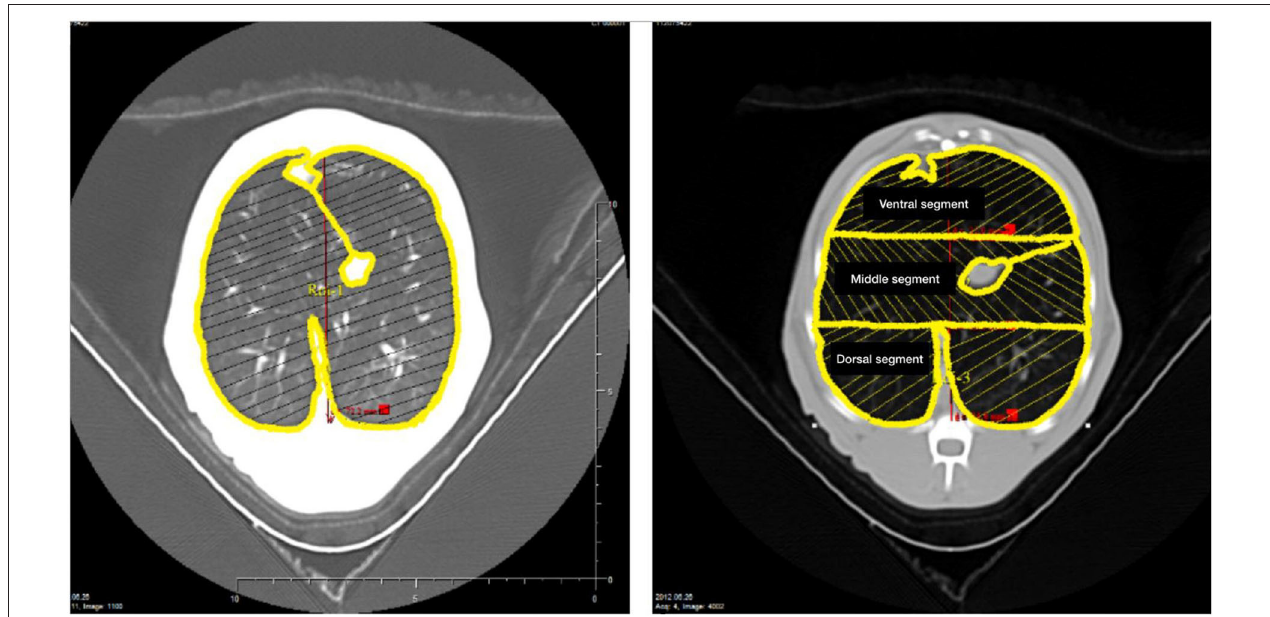
FIGURE 1 | The left panel shows the delineation of the region of interest encompassing the left and right lungs performed in a juxta-diaphragmatic CT section. The right panel shows the delineation of 3 regions of interest of equal height distributed along the ventral-dorsal axis (ventral, middle, and dorsal lung segments) encompassing the left and right